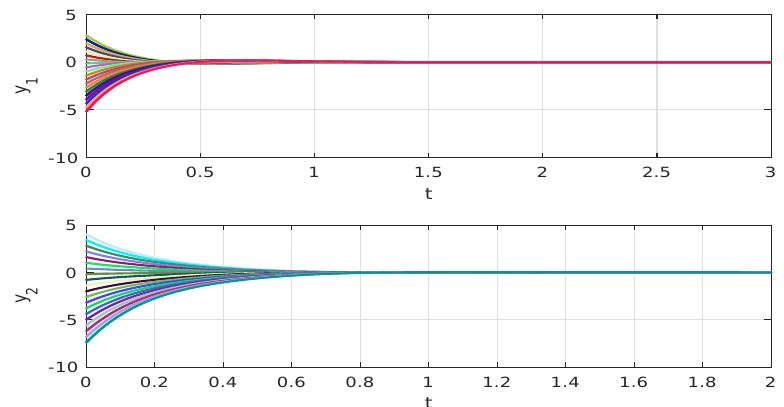
Figure 11. An illustration of the time responses with respect to the imaginary parts pertaining to the model in (20), in which ˜ u ( t ) = 0 in Example 3.